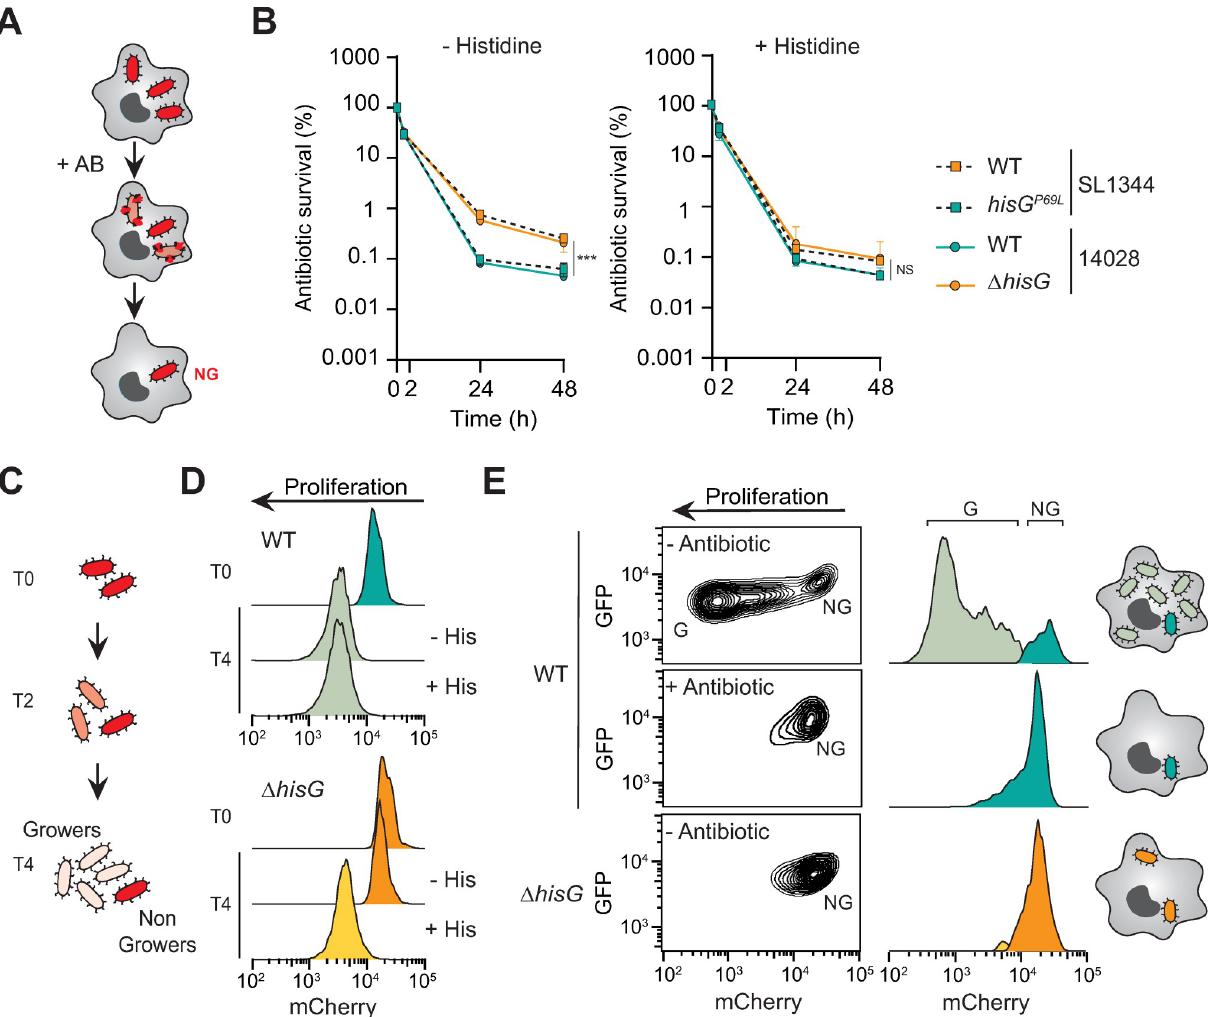
Fig 2. Growth dynamics at the single cell level discriminates antibiotic tolerance from persistence in cellulo . ( A ) Illustration of the in cellulo antibiotic survival assay in primary Bone Marrow Derived Macrophages (BMDM) infected with Salmonella . ( B ) CFU enumeration of WT or hisG P69L SL1344 Salmonella as well as WT or Δ hisG 14028 Salmonella in BMDMs treated with cefotaxime in the absence or presence of histidine in the infection medium. Data represent the mean and SD of at least three biological repeats. Data from the 48 h timepoint were compared using one way ANOVA with Tukey’s multiple-comparison test, ��� p < 0.001; NS, not significant. ( C ) Illustration of the fluorescence dilution assay to assess growth dynamics of a population at the single cell level. Growing cells dilute a pre-formed pool of mCherry at each cell division whereas the non-growing bacteria maintain high intensity fluorescence. ( D ) Representative flow cytometry profile of Salmonella 14028 grown in minimal medium for 4 h in the absence or presence of histidine for WT and Δ hisG strains. ( E ) Representative flow cytometry contour (left) and histogram (right) plots of bacteria extracted from BMDM after 16 h of gentamicin (- antibiotic condition) or 16 h of cefotaxime (+ antibiotic condition). G, growers and NG, non-growers.